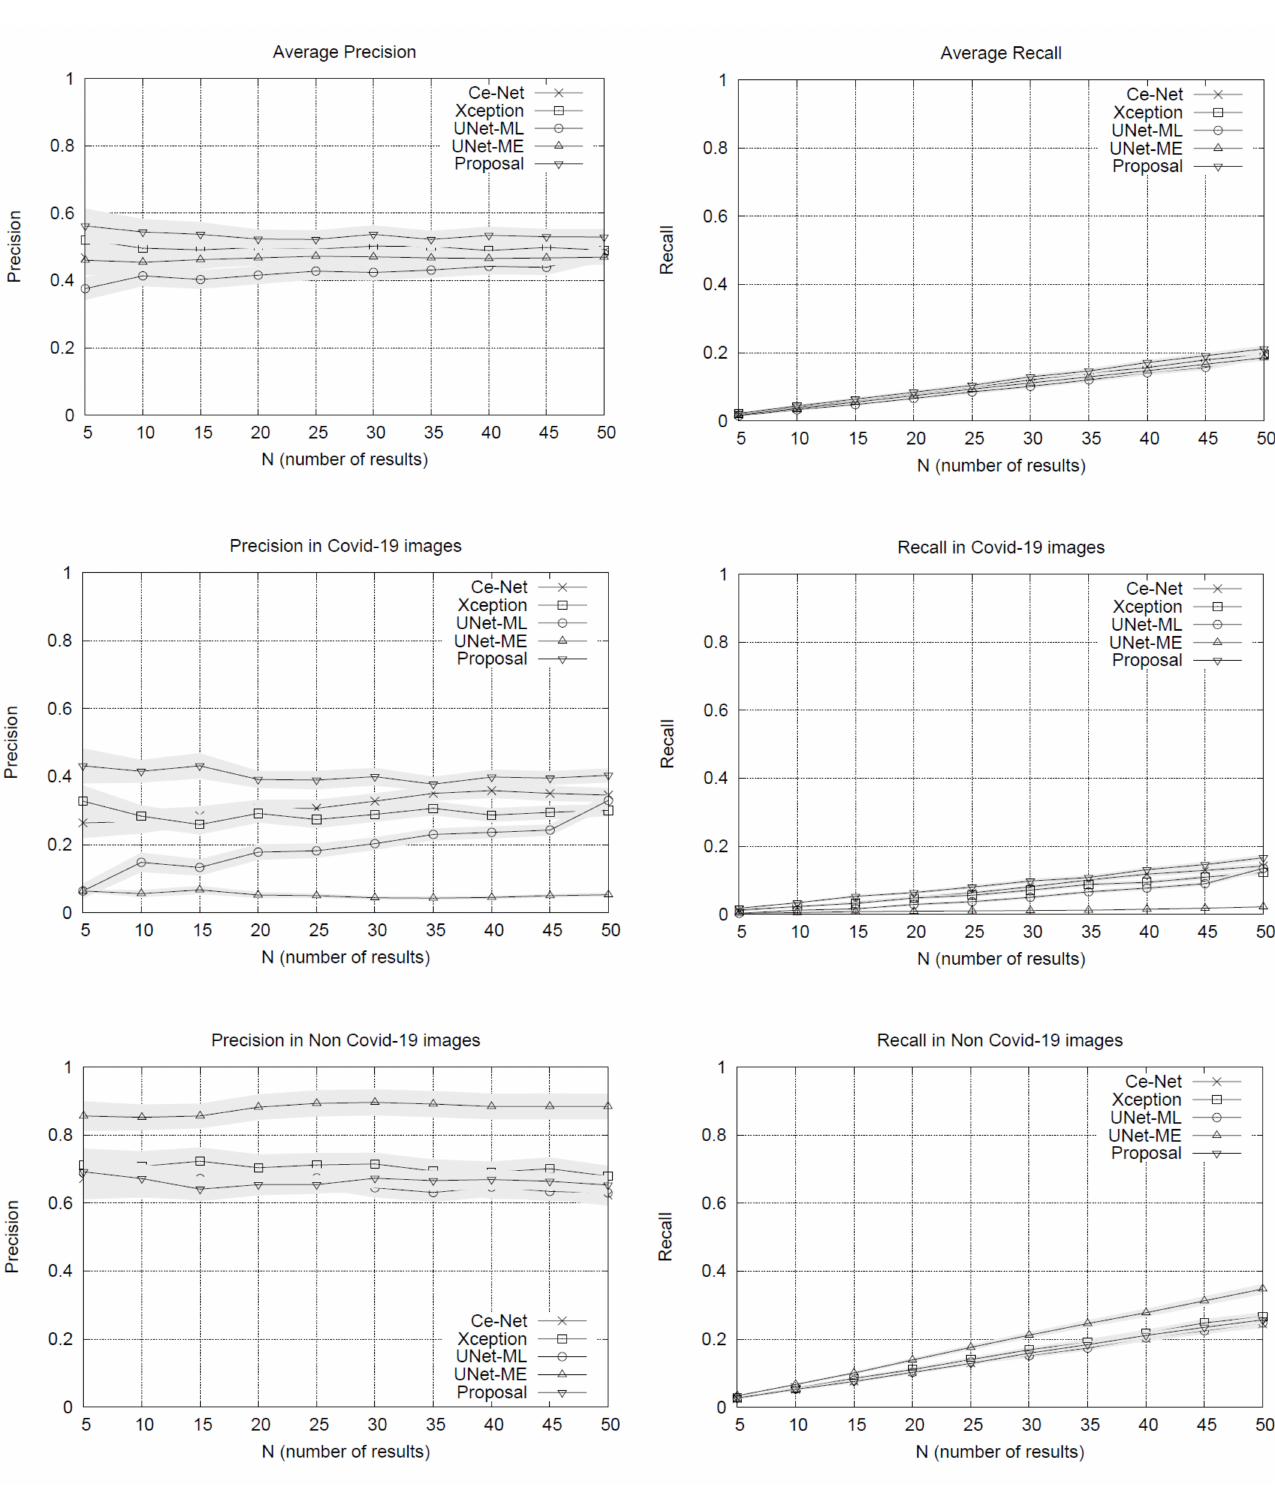
Figure 1. Precision and recall scores of the methods evaluated in this study. The plots at the top show the whole set of images’ performance, while the plots at the bottom show the results disaggregated by